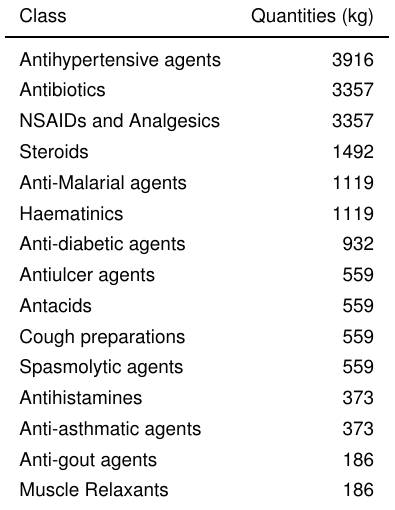
Table 2. Projected Quantities of Medicines Disposed of in an Unregulated Manner by Attendants to Clinics (Cal- culated by authors using figures Cocoa Clinic and Ghana Health